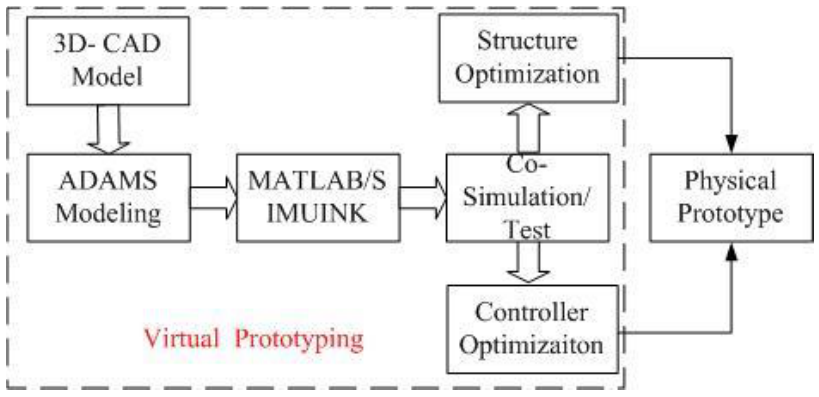
Figure 8. Flow chart of electromechanical